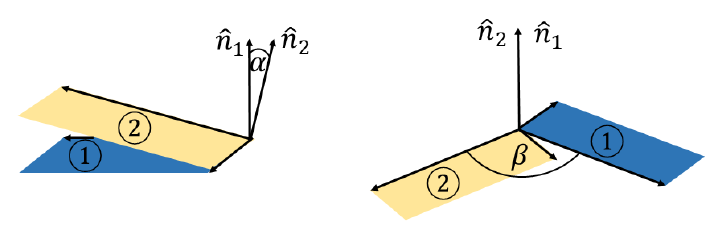
−→ −→ Figure 2. Vectors C 20 C 3 and C 20 C 19 describing incline angle α doxh and rotational angle β of two DOXHs where ˆ n 1 and ˆ n 2 are the normal vectors of the plane two planes indicated by 1 (cid:13) and 2 (cid:13)